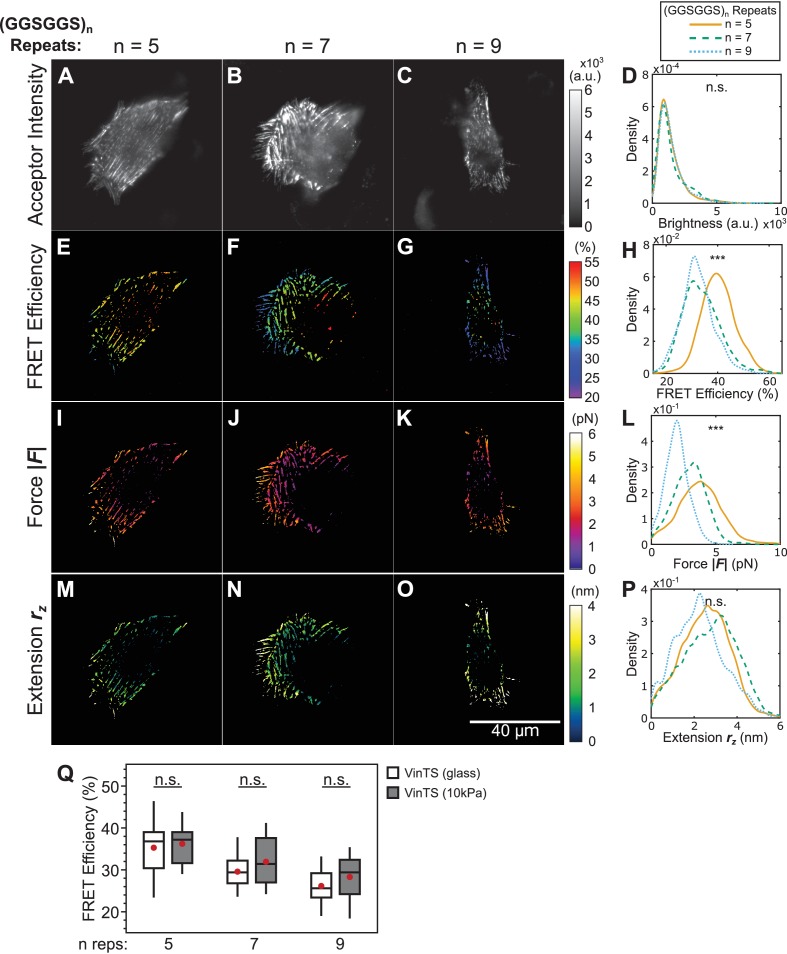
Effect of substrate stiffness on vinculin extension-control.(A-C) Representative images of the localization of a trio of vinculin tension sensors to FAs formed in cells plated on fibronectin-coated 10 kPa gels. (D) Normalized histograms of acceptor intensities at FAs are indistinguishable between the three sensors. (E-G) Representative images of masked FRET efficiency and (H) normalized histograms of average FA FRET reported by each sensor. (I-K) Representative images of forces and (L) normalized histograms of average vinculin force in FAs reported by each sensor. (M-O) Representative images of extension and (P) normalized histograms of average vinculin extension in FAs reported by each sensor. Note that ~8% of FAs exhibited negative forces/extensions and were excluded from the analysis in panels L and P. All normalized histograms depict data from individual FAs; n = 25, 25, 14 cells and n = 2569, 3251, 1800 FAs for (GGSGGS)5,7,9 extensible domains, respectively; data pooled from three independent experiments; ***p<0.001, n.s. not significant (p≥0.05), ANOVA. (Q) Quantification of cell-average FRET efficiency in VinTS-expressing cells plated on glass compared to 10 kPa gels; data represents ≥14 cells per condition, pooled from three independent experiments; red filled circle denotes sample mean; n.s. not significant (p≥0.05), Student’s t-test, two-tailed, assuming unequal variances. See Supplementary file 4 for exact p-values and multiple comparisons test details.